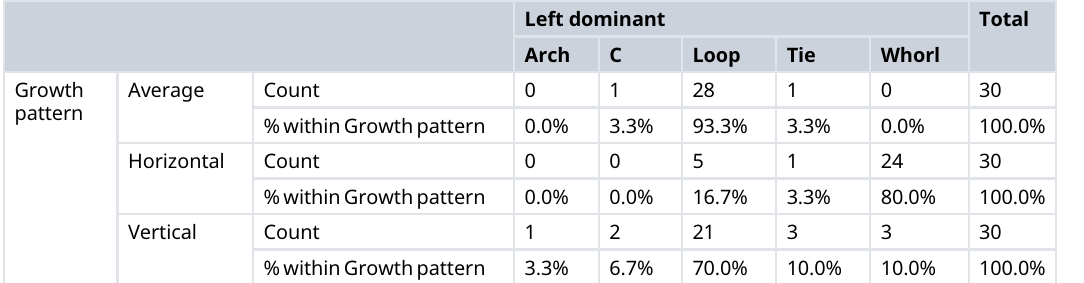
Table 1. Overall comparison for between groups (Left